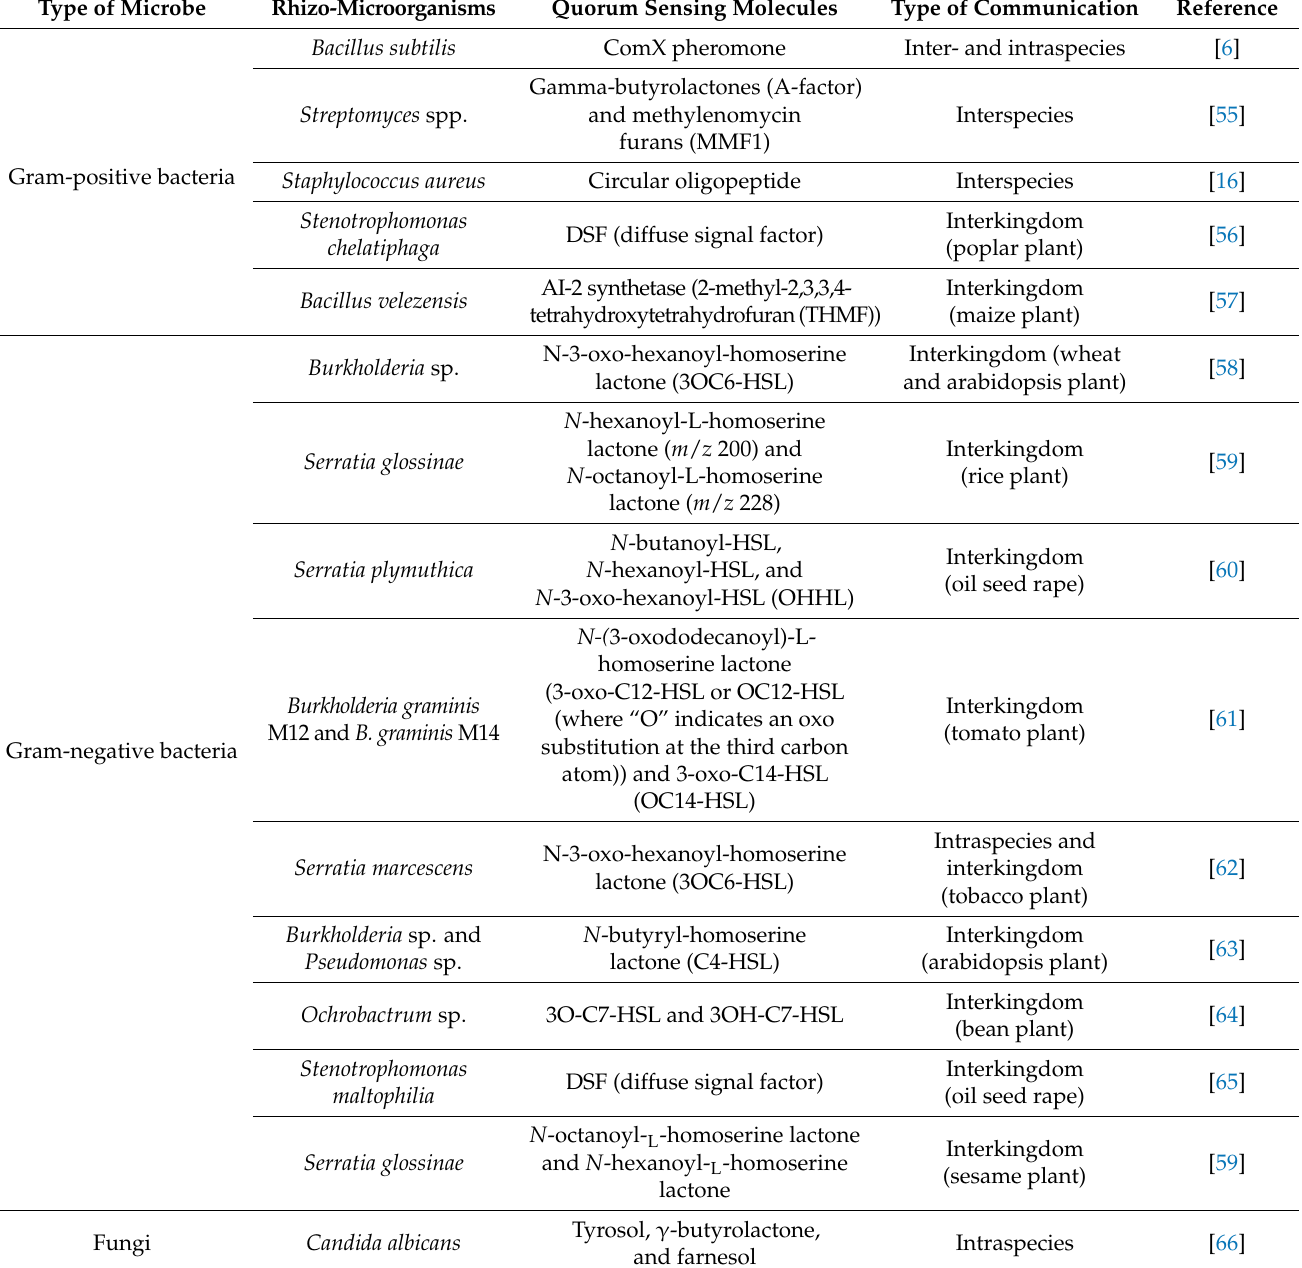
Table 1. Characterization of quorum sensing signaling molecules that are produced by different rhizomicrobes with respect to the type of communication within the